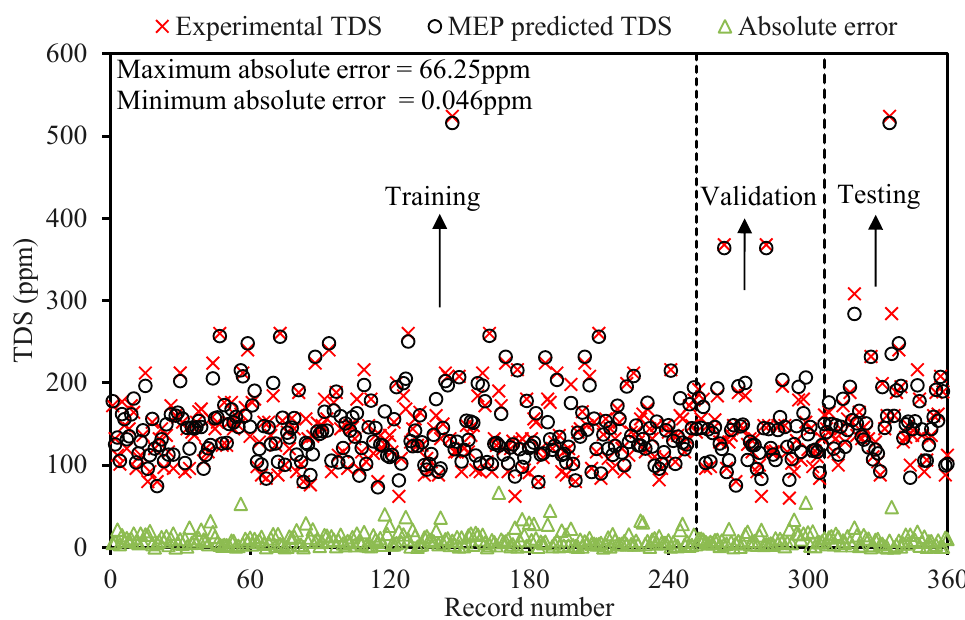
Figure 6. Absolute error plot of MEP model established for TDS.